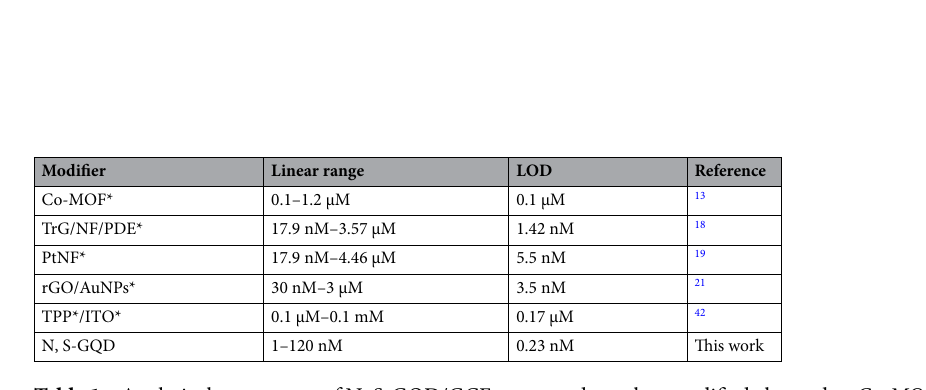
Table 1. Analytical parameters of N, S-GQD/GCE compared to other modified electrodes. Co-MOF Co based metal organic anion framework, TRG/NF/PDE Thermally reduced graphene/nafion modified